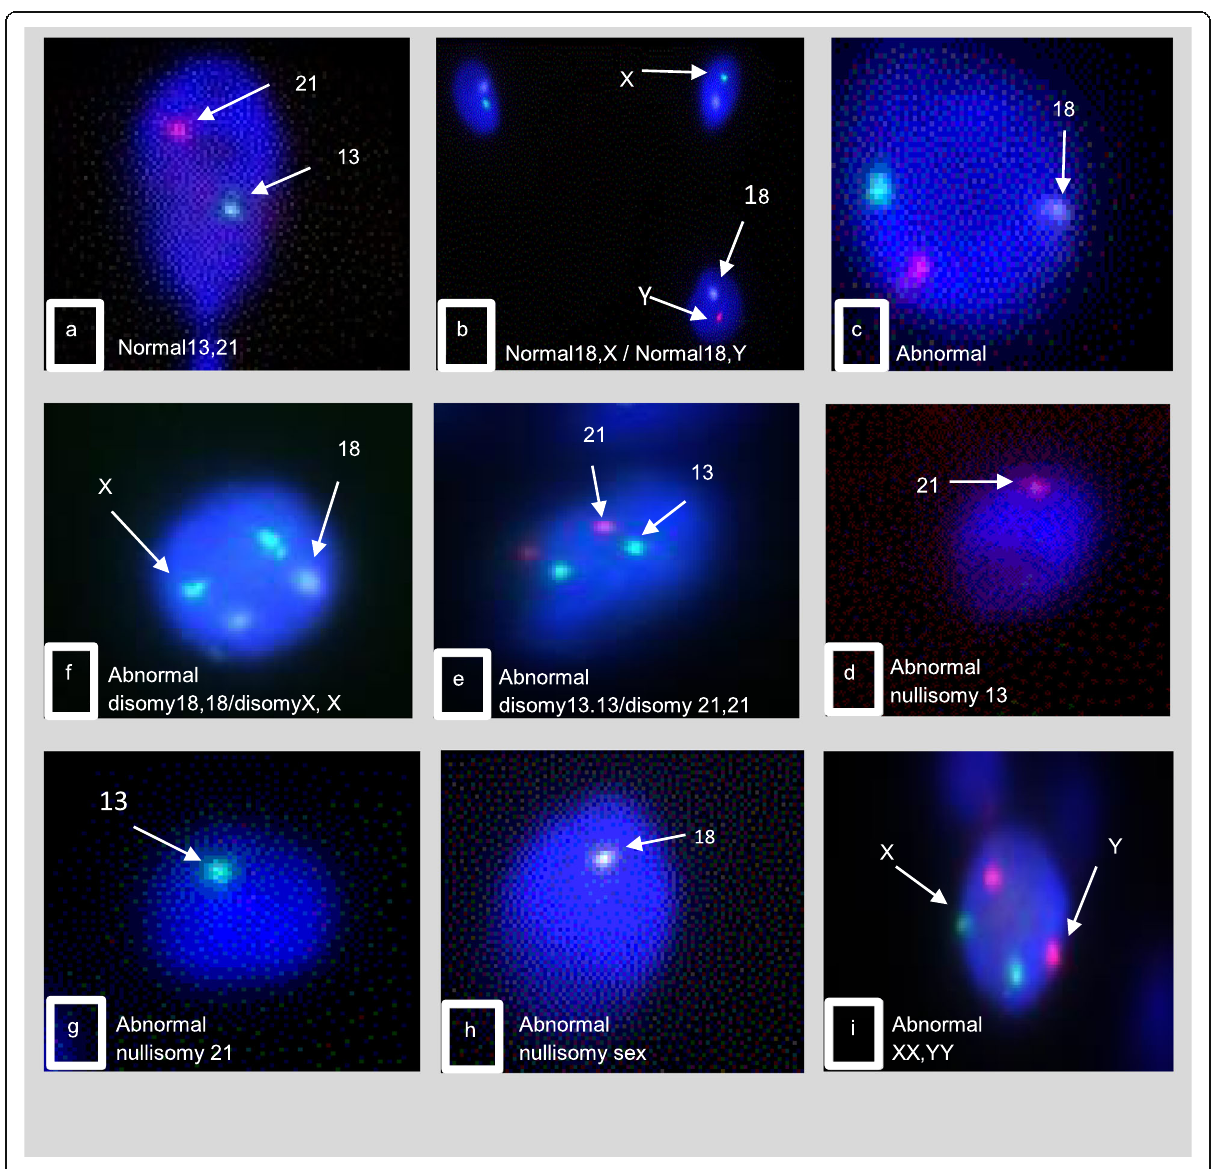
Fig. 2 Examples of sperm fluorescent in situ hybridization (FISH) showed under a fluorescence microscope. Clockwise from top left: a normal sperm, b normal sperm, c Abnormal sperm with normal chromosome 18 and XY, d Sperm with normal chromosome 21 and nullisomy13, e Sperm with chromosome13 and 21 disomy, f Sperm with chromosome x and 18 disomy, g Sperm with normal chromosome 13 and nullisomy 21, h Sperm with normal chromosome 18 and nullisomy sex, i Sperm with chromosome XX,